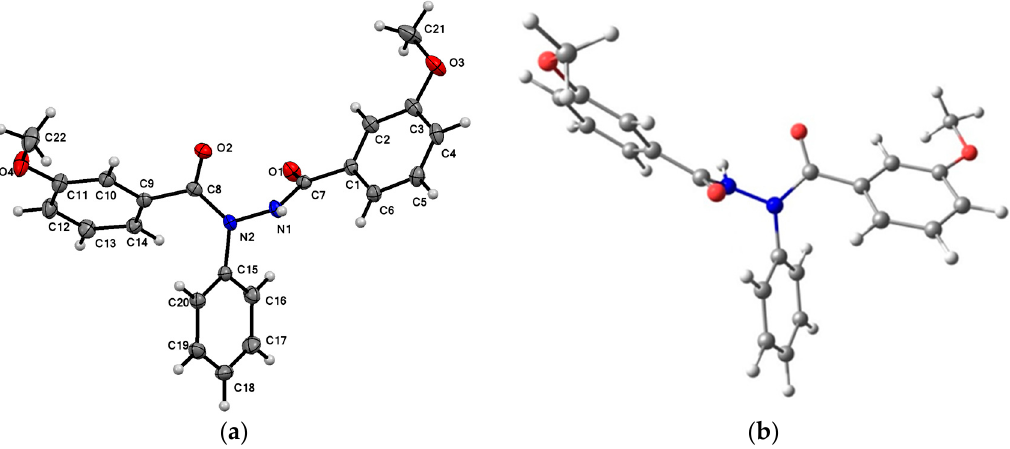
Figure 1. ( a ) A view of the crystal structure of the title compound 1 and ( b ) a view of an optimized structure from DFT calculations.